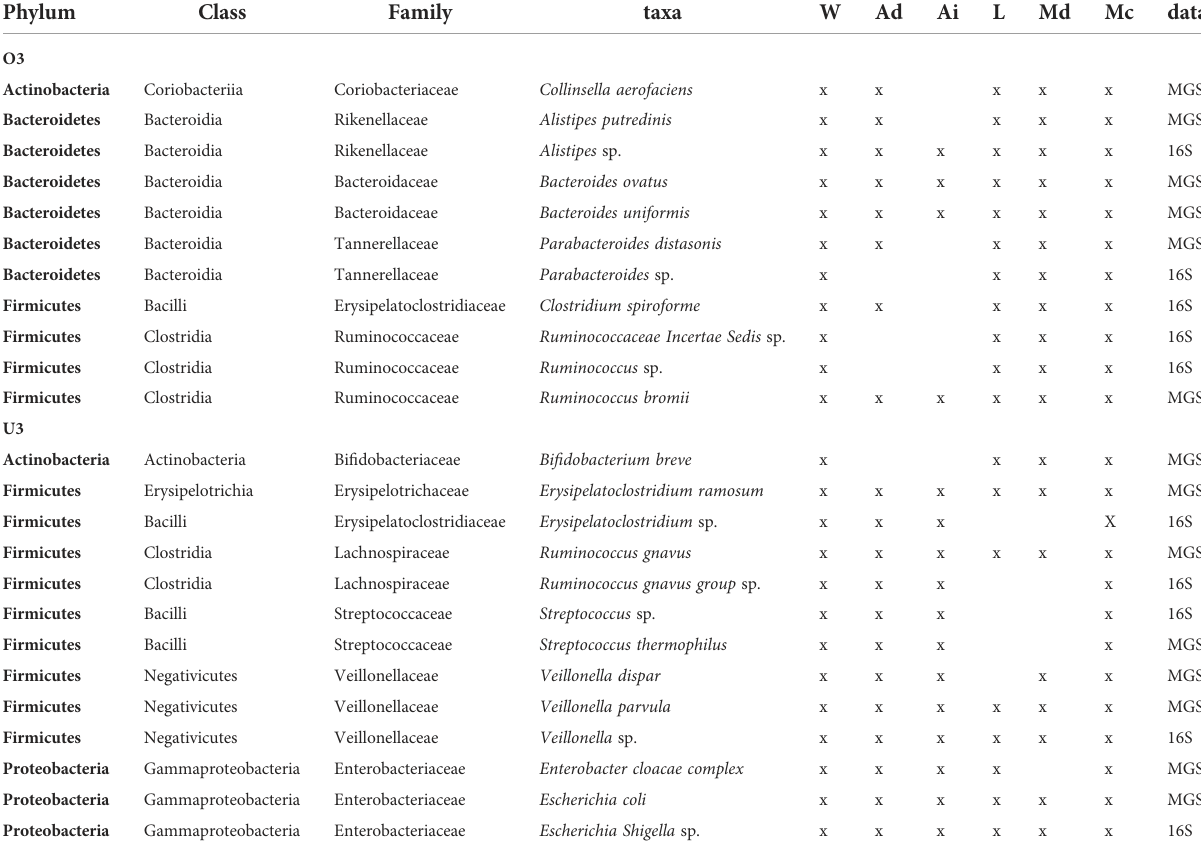
TABLE 4 Taxa identi fi ed as signi fi cantly increased in 4 or more differential abundance analysis methods based on age category (over 3 years O3 and under 3 years U3 of age) using 16S and MGS data.